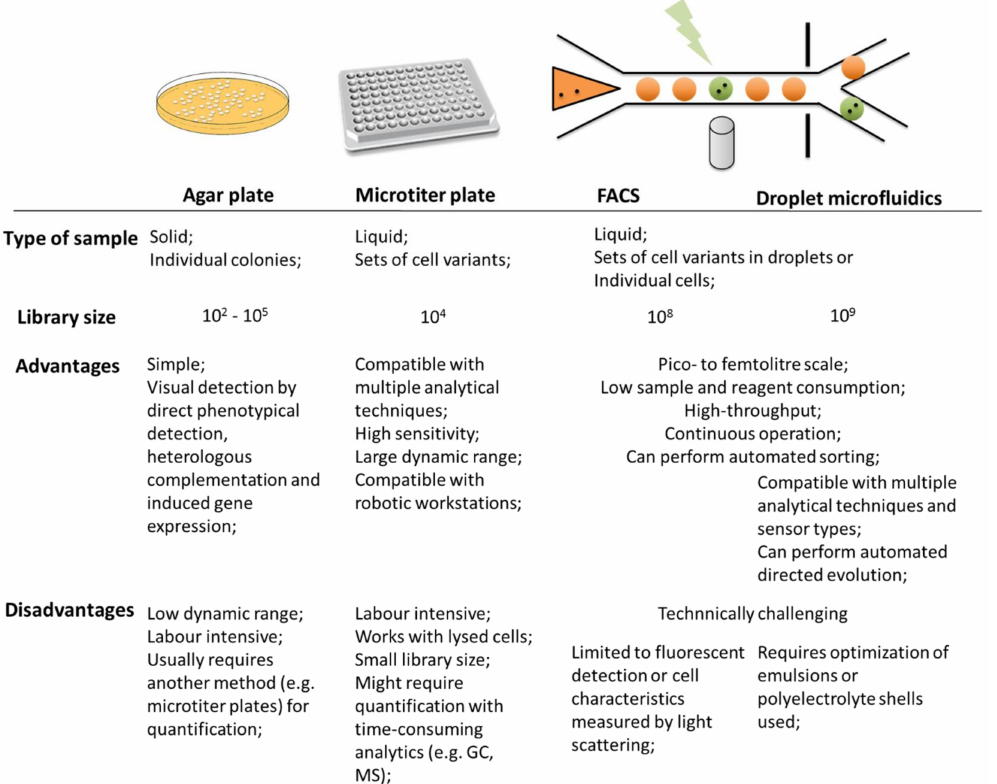
Figure 1. Summary of some of the advantages and disadvantages of the commonly used screening approaches for whole cell biocatalysts. GC: gas chromatography; MS: mass